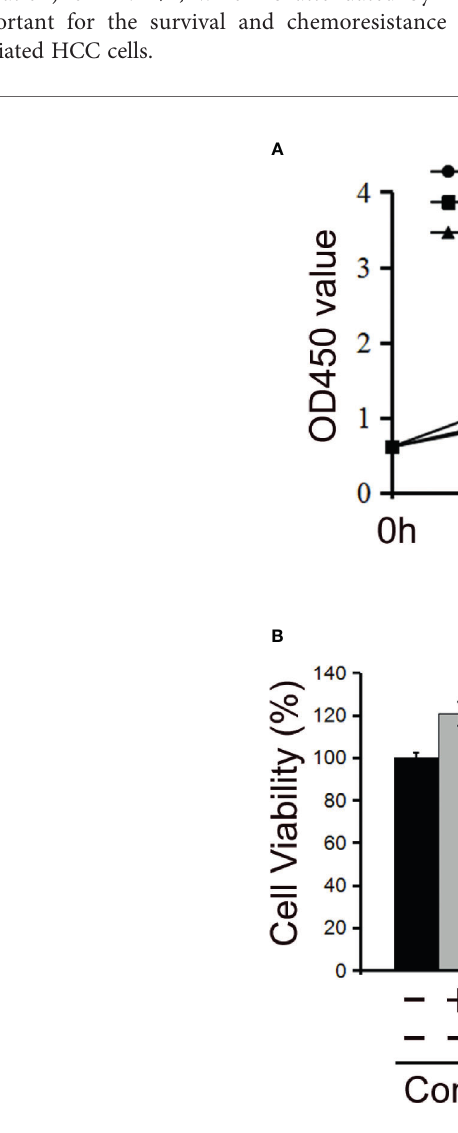
FIGURE 3 | PD98059, the ERK1/2 inhibitor, attenuates GCDA-mediated survival and drug-resistance in HCC cells. (A) PD98059 could inhibit phosphorylation of ERK1/2. QGY-7703 cells were preincubated with PD98059 (10 m M) for 0.5 h, followed by treatment with 100 m M GCDA for 24h, 48h and 72h. CCK8 was performed to determine the viable cells. (B) QGY7703 cells were treated with or without PD98059 (10 m M) for 0.5 h, followed by treatment with GCDA (100 m M) or GCDA(100 m M) +antitumor drug (1 m g/ml 5-FU) for 72h. Then CCK8 was performed to determine the viable cells. Data in graphs are as mean±SD. All experiments data were repeated at least three independent experiments. *P < 0.05, **P < 0.01 (Student ’ s